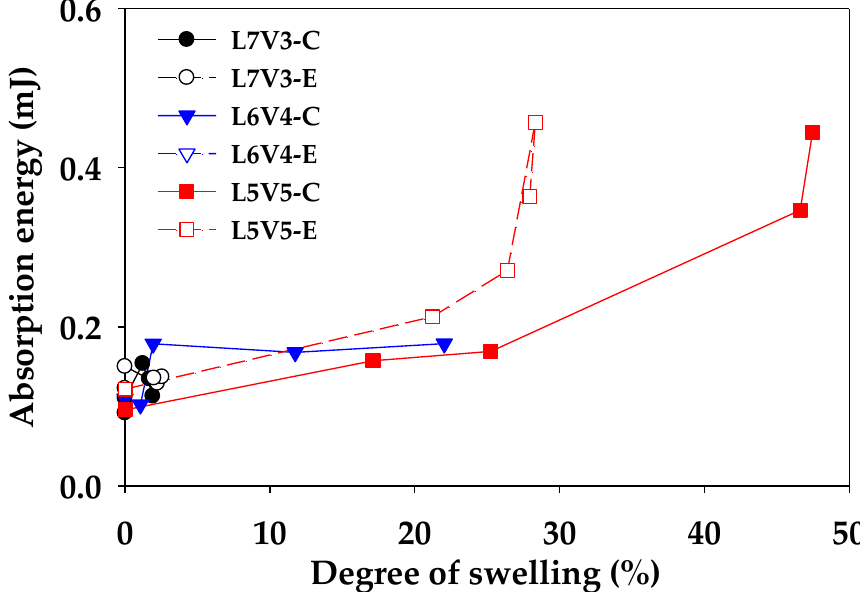
Figure 17. Relationship between the absorption energy and the degree of swelling.